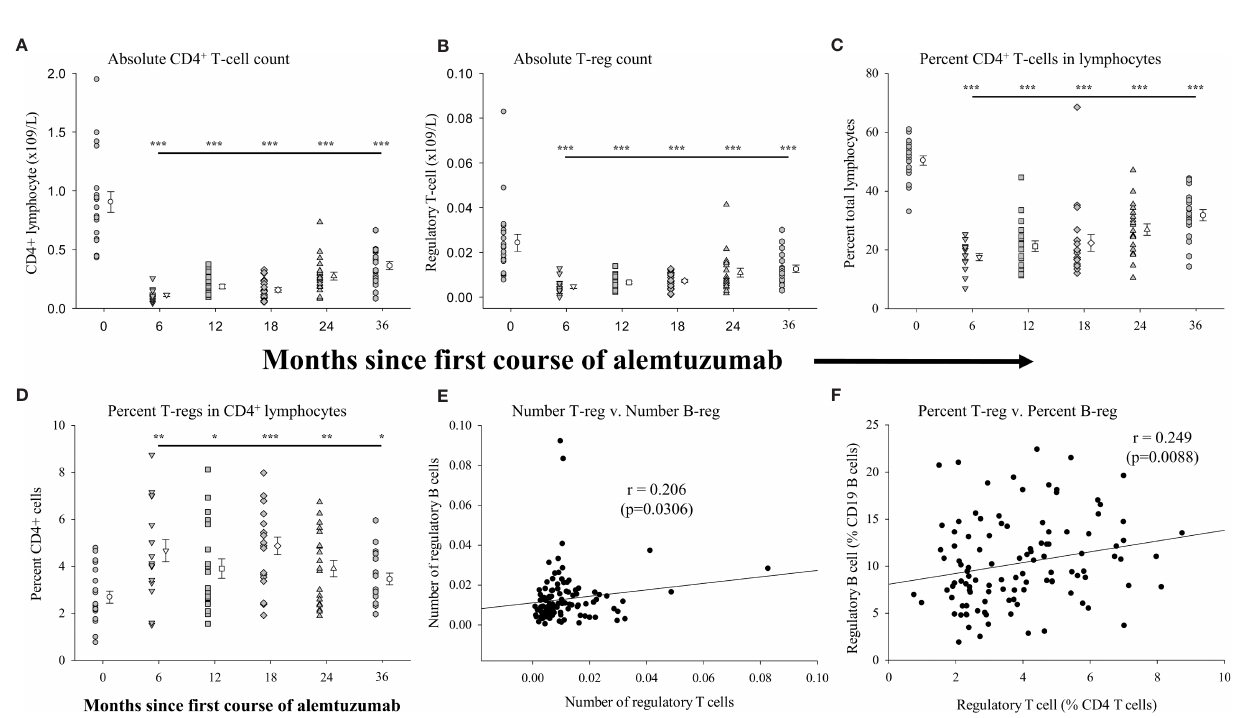
FIGURE 3 | Measures of peripheral blood regulatory T-cells following alemtuzumab treatment: Panels (A – D) illustrate different measures for each treatment cohort (6 month = inverted triangle; 12 month = square; 18 month = diamond; 24 month = triangle; 36 month = hexagon) as compared with a pre-treated patient cohort (circles). Panel (A) shows the absolute number of CD4 + T lymphocytes per liter of blood. Panel (B) shows the absolute number of CD4 + CD25 hi CD127 lo/neg FoxP3 + regulatory T lymphocytes per liter of blood. Panel (C) shows the percent of CD4 + T lymphocytes found within the total lymphocyte population. Panel (D) shows the percent of CD4 + with a CD25 hi CD127 lo/neg FoxP3 + regulatory phenotype. Data for each cohort in panels (A – D) shows the individual values for each patient in the cohort ( fi lled circles, fi lled triangles etc.) adjacent to the mean ( ± SEM) for the group as a whole (open circles, open triangles etc.). Signi fi cant changes compared to the pre-treated patient cohort are identi fi ed as *** (p ≤ 0.001), ** (p ≤ 0.01), * (p ≤ 0.05) or ns (not signi fi cant), and are plotted above the corresponding cohort on top of the solid back line. Panels (E, F) show scatter plots and Spearman ’ s Rank-Order correlations (rho (r)) of the number of regulatory T lymphocytes (x-axis) versus the number of regulatory B lymphocytes (E) or percent of regulatory T lymphocytes (x-axis) versus the percent of regulatory B lymphocytes (F) for all data points in the